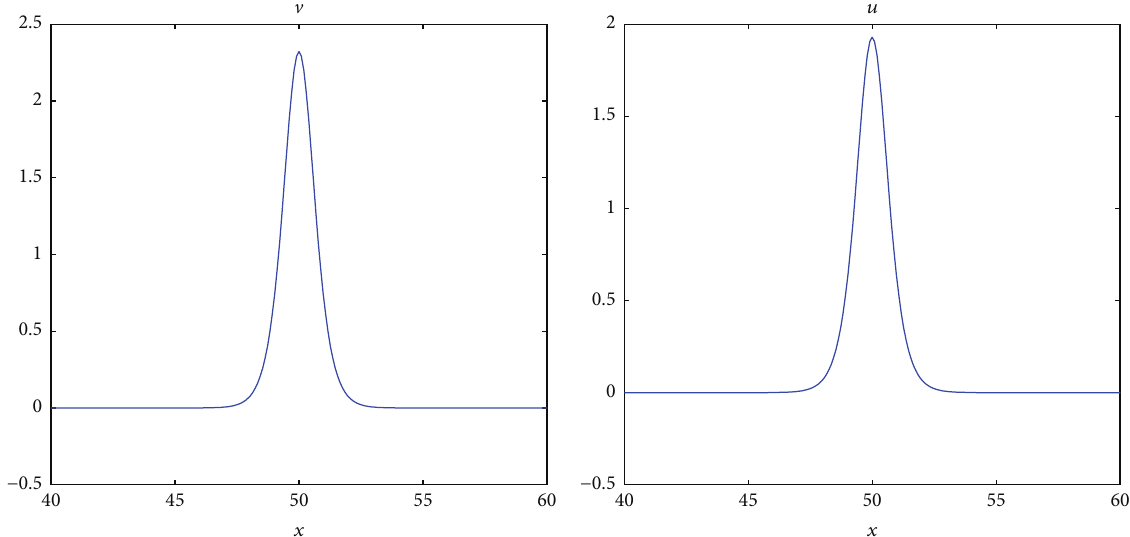
Figure 9: Solitary wave solution of system (75) for 𝛼 = 𝛽 = 0.5 , 𝜎 = 0.5 , and wave speed 𝑐 = 1.5 , obtained after 5 Newton’s